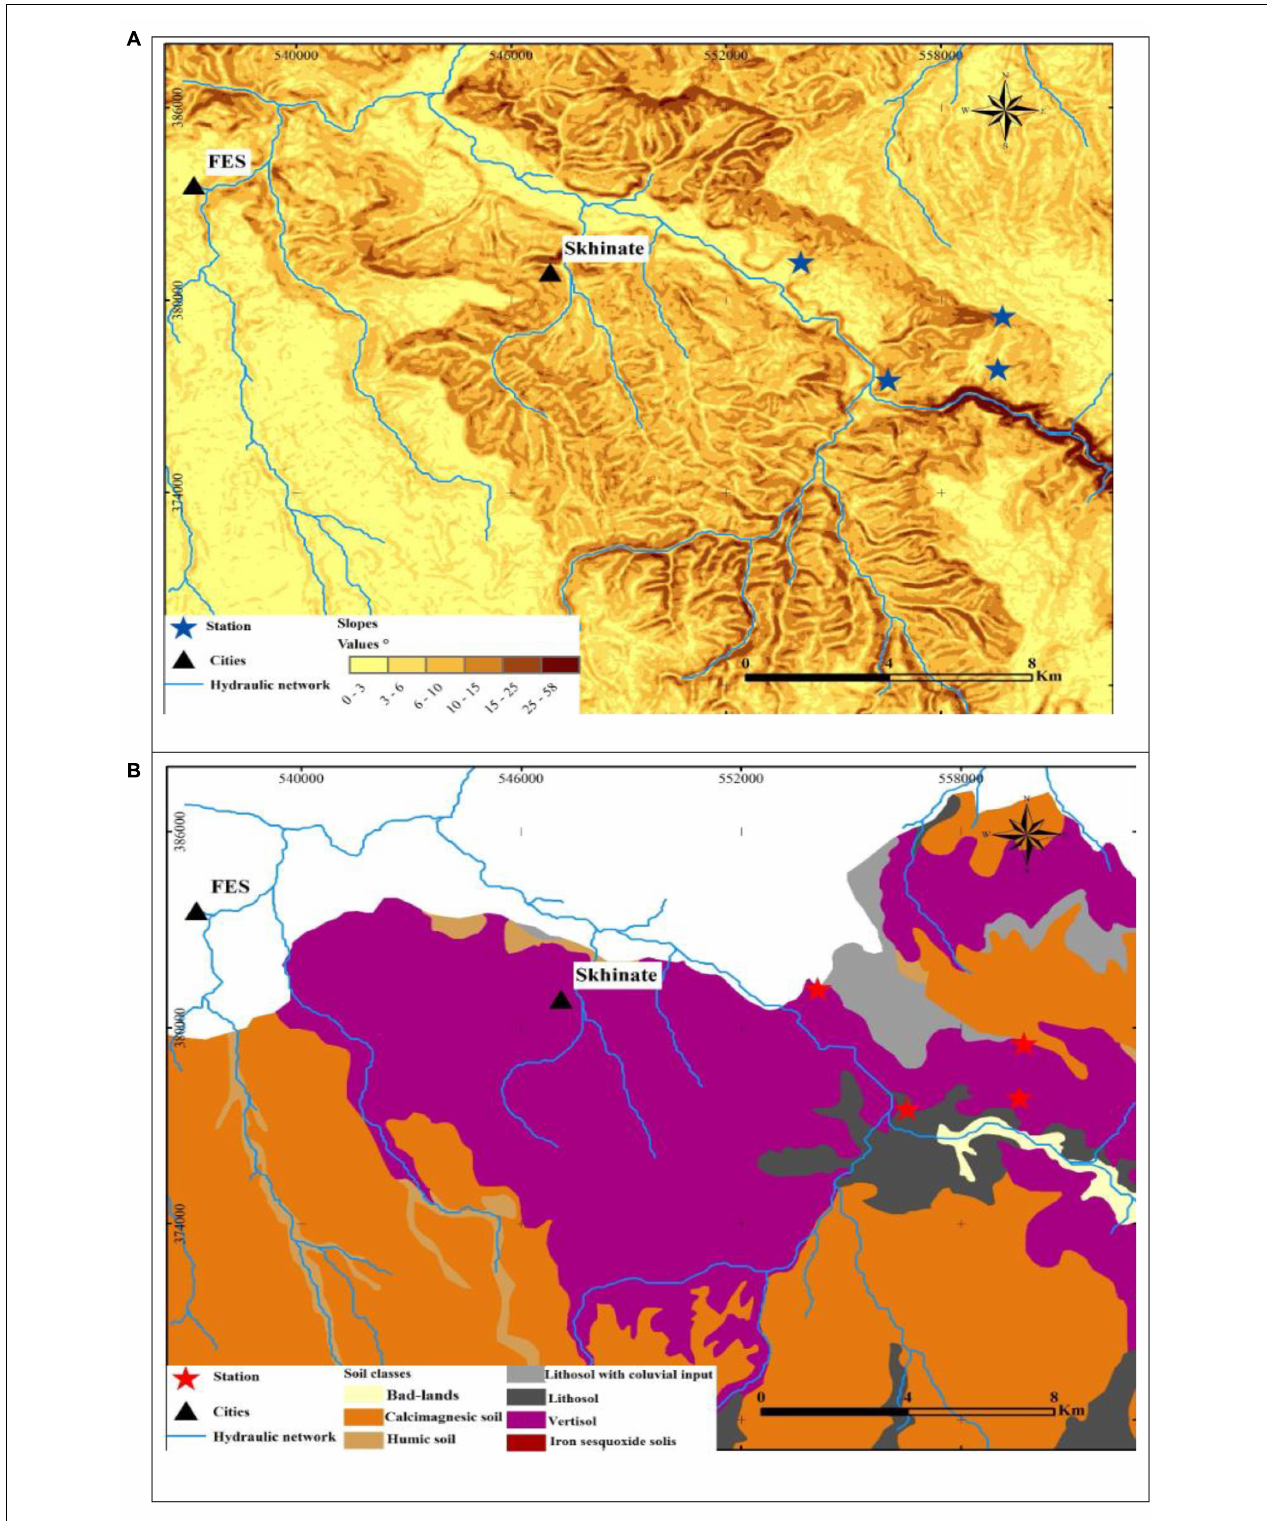
FIGURE 2 | Geological maps of the study stations (A1, A2, A3, and A4). (A) Map of slope classes; (B) soil map.